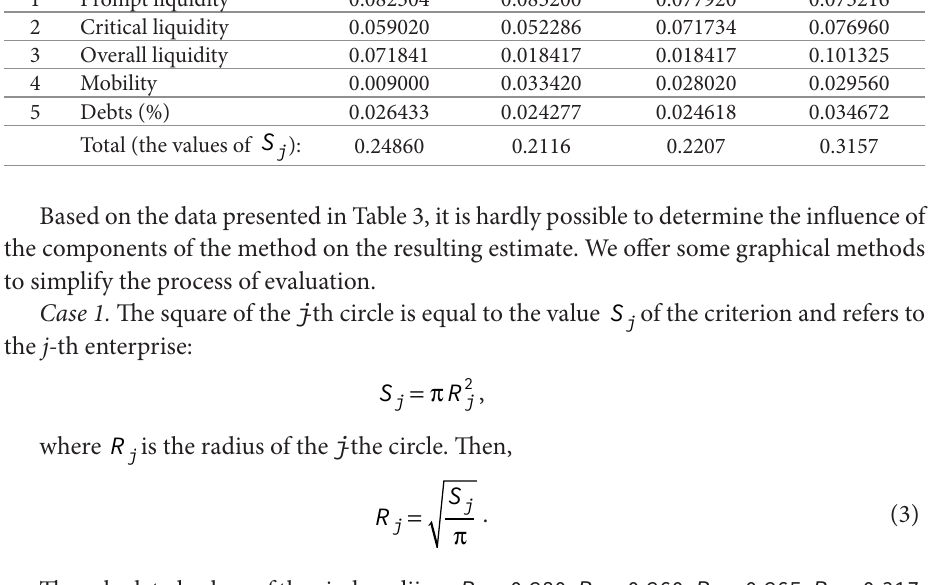
Table 3. Normalized weighted values of the criteria No.